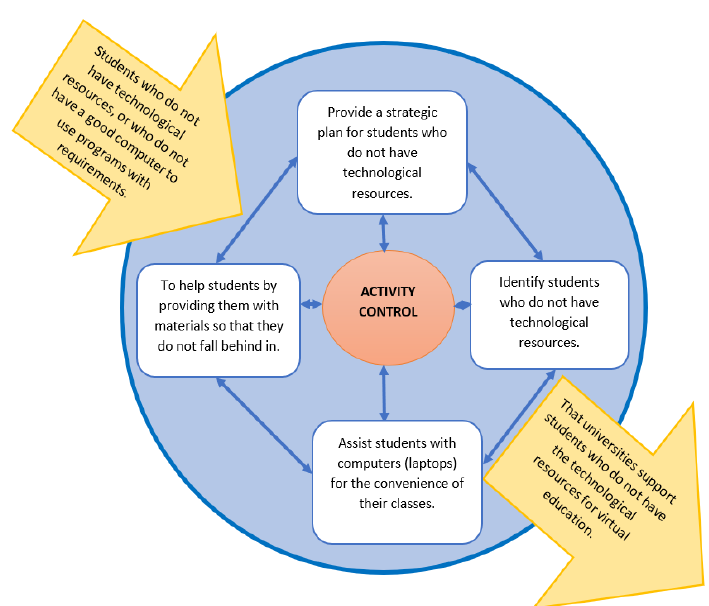
Fig. 11. Conceptual model applied to